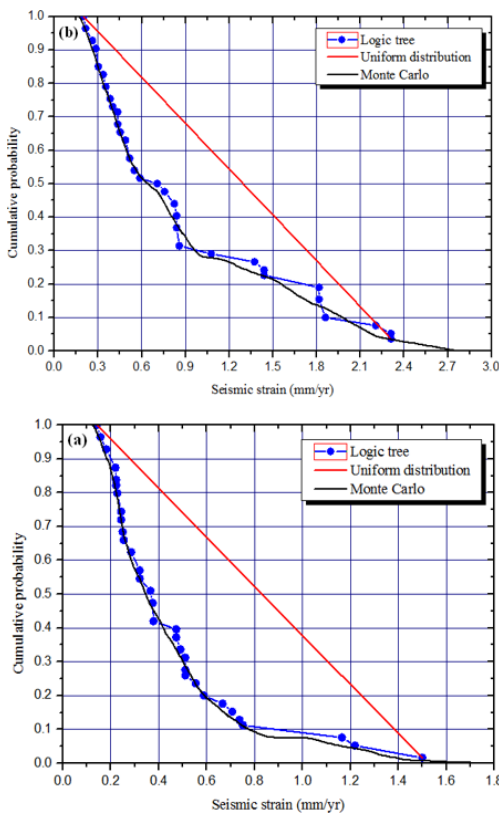
Figure 6. Monte Carlo method applied to Vilanova and Fonseca (2007) logic tree models, compared with a uniform probability dis- tribution. (a) The LTV source zone. (b) The 1755 source